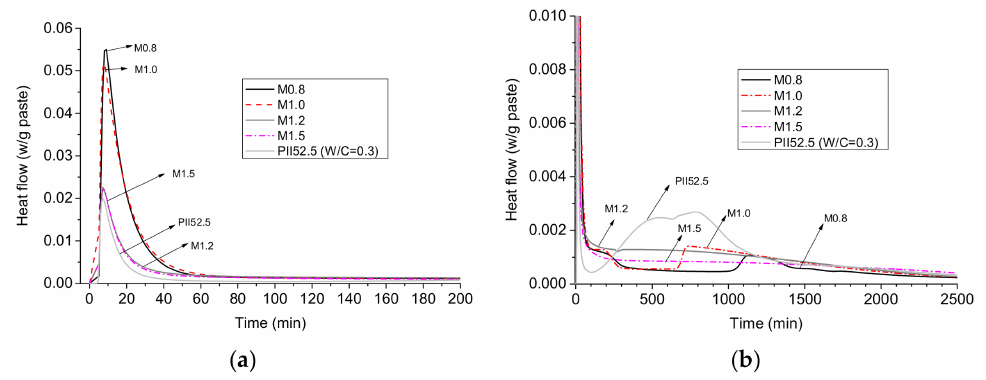
Figure 15. Effect of SiO 2 to Na 2 O ratio on exothermal rate of the geopolymer coating. ( a ) Exothermal rate at early age; ( b ) Exothermal rate at late